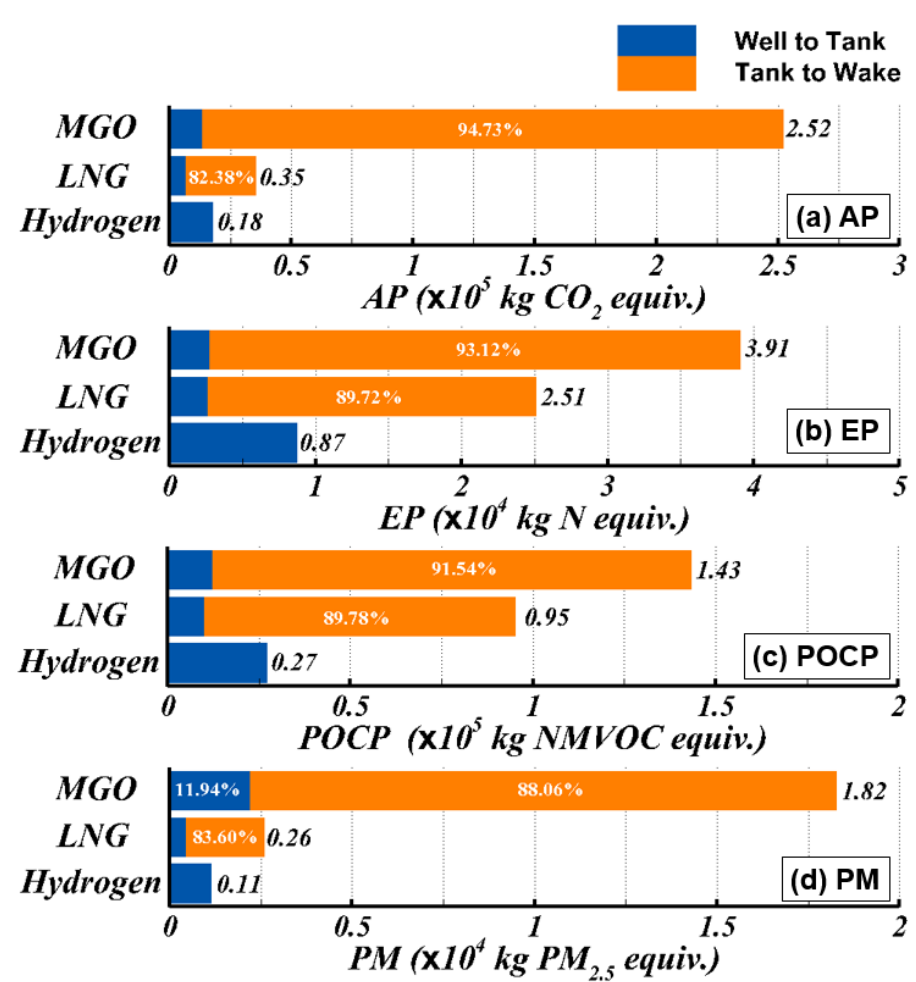
Figure 20. ( a ) AP, ( b ) EP, ( c ) POCP, and ( d ) PM results in the well-to-wake phase. Figure 20. AP, EP, POCP, and PM results in the well-to-wake